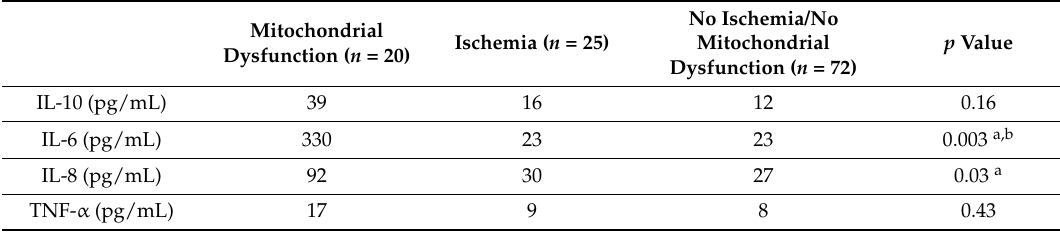
Table 3. Blood cytokine levels (median values) in the three groups defined as mitochondrial dysfunction, ischemia, and no ischemia/no mitochondrial